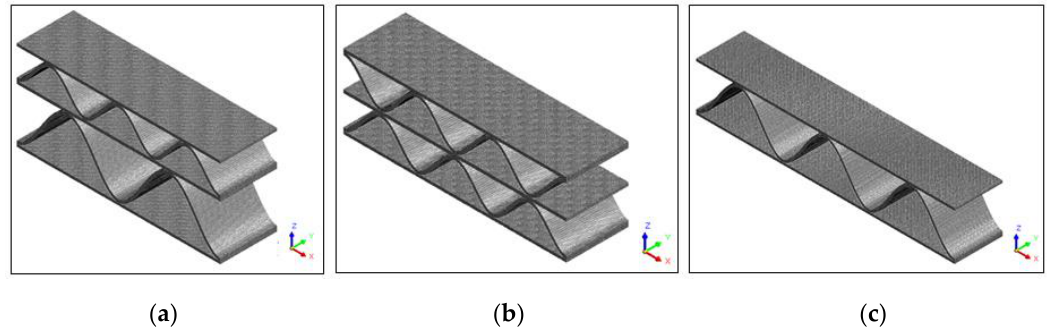
Figure 5. The FE (finite element) models for the unit cells of the target corrugated paperboard; they should be listed as: ( a ) AB/F-DW, ( b ) BB/F-DW, and ( c ) A/F-SW (Table 1).